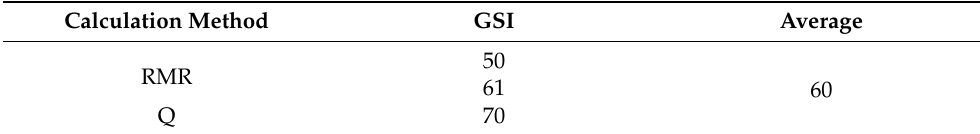
Table 4. Rock mass quality evaluation results based on